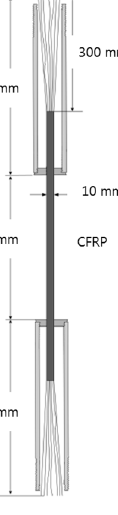
Figure 2. Dimensions of a typical sample specimen.